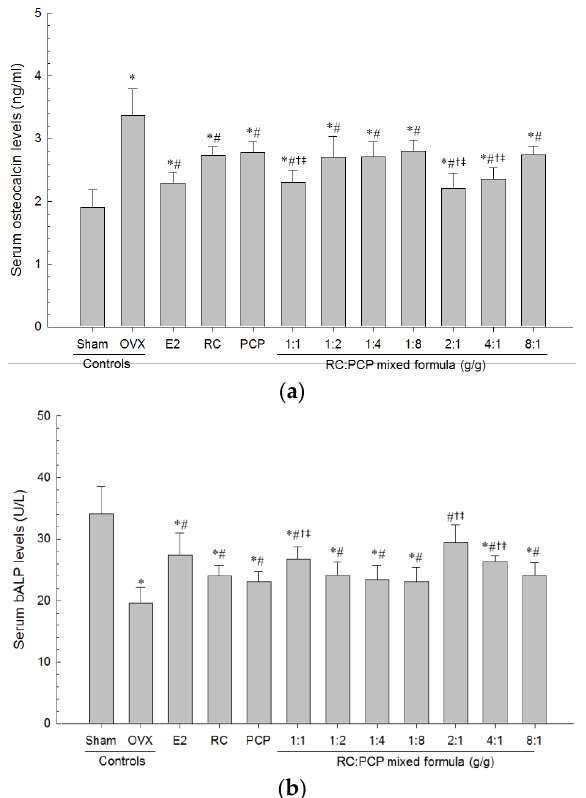
Figure 7. Serum ( a ) Osteocalcin and ( b ) bALP Levels in Sham-operated or OVX ddY Mice. Values are expressed mean ± S.D. of eight mice. OVX = Ovariectomy; E2 = 17β-estradiol; RC = Red clover dry extracts; PCP = Pomegranate Concentrate Powder; RC:PCP = Mixed formulations consisted of RC and PCP (g/g). * p < 0.05 as compared with sham control; # p < 0.05 as compared with OVX control; † p < 0.05 as compared with RC single formula treated mice; ‡ p < 0.05 as compared with PCP single formula treated mice.